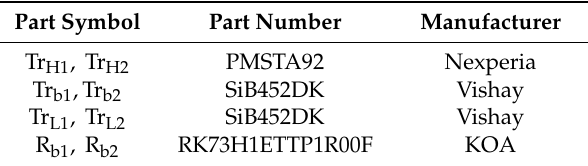
Figure 6. Design of fabricated circuit. Table 1. Electrical component list.